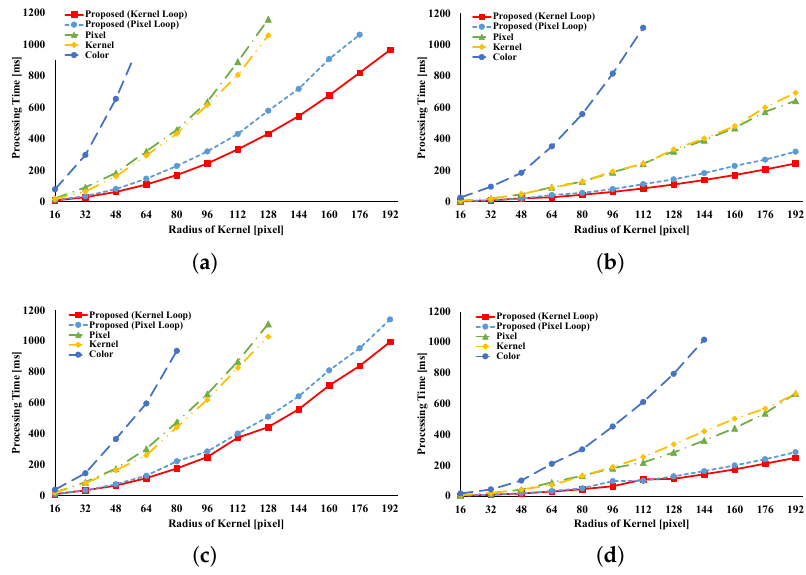
Figure 16. Processing time for randomly-kernel-subsampled bilateral filtering (RKS-BF) with respect to the kernel radius of FIR filtering. ( a ) 1/4 subsample in weight computation; ( b ) 1/16 subsample in weight computation; ( c ) 1/4 subsample in LUT; ( d ) 1/16 subsample in LUT. Arbitrary pixel loop unrolling and arbitrary kernel loop unrolling are used in place of pixel loop unrolling and kernel loop unrolling, respectively.